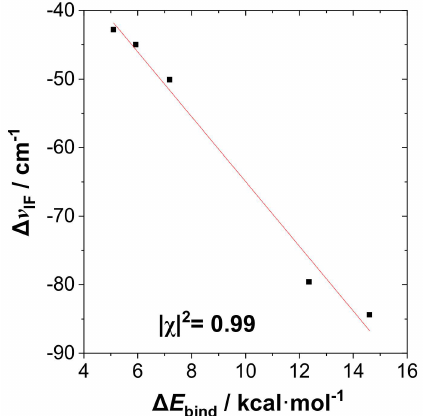
Figure 3. The trend of frequency shift, ∆ ν IF , with the R-substituent in the RPH 2 ··· IF complexes for four theoretical levels (cf. Figure 2).